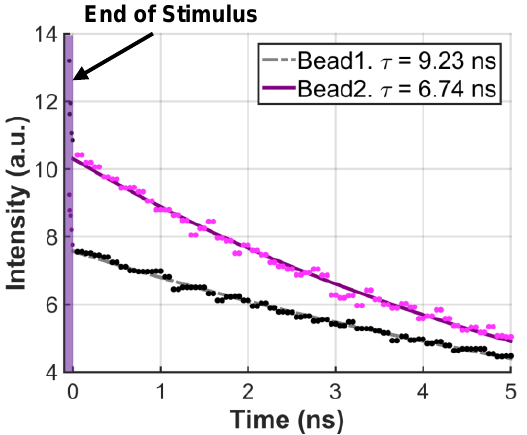
Figure 18. Lifetime extraction for quantum dots (Bead1: QSP-560, Bead2: